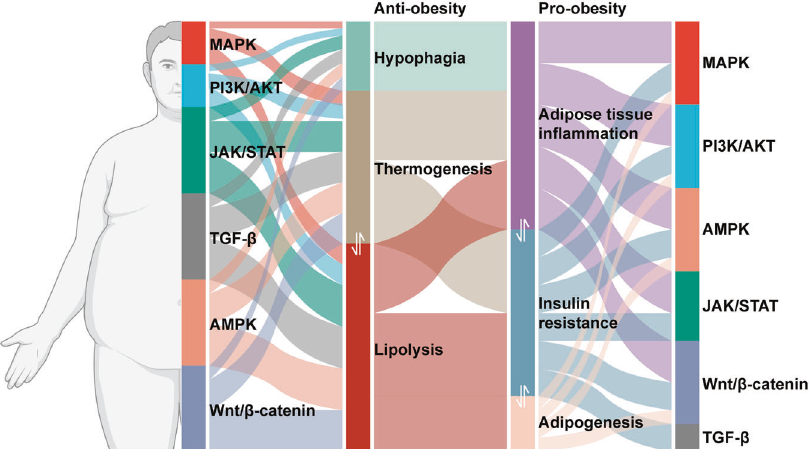
Fig. 1 Signaling pathways involved in pro-obesity and anti-obesity mechanisms. Insulin resistance, adipose tissue in fl ammation, and adipogenesis constitute pro-obesity mechanism. Anti-obesity mechanism is composed of thermogenesis, lipolysis, and